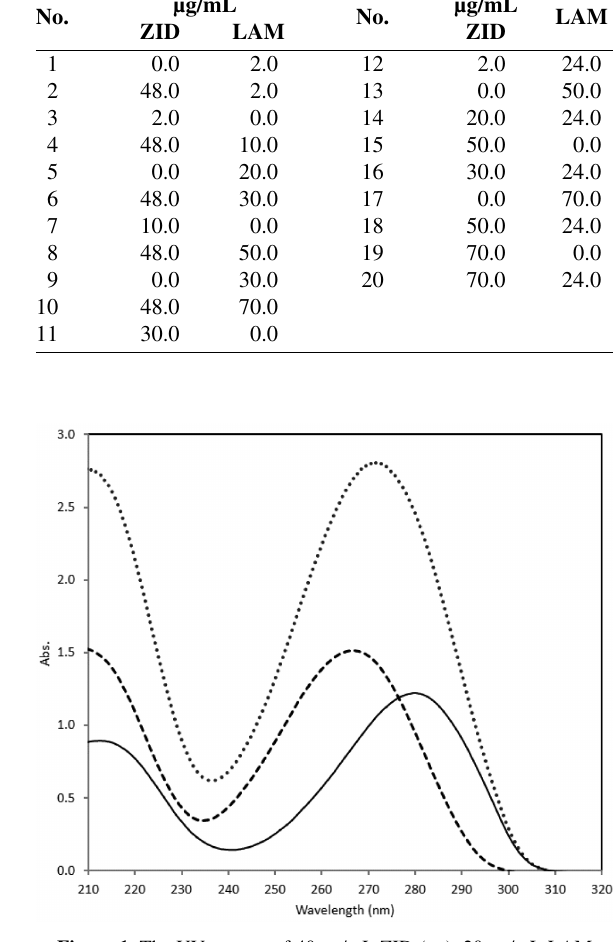
Figure 1. The UV spectra of 40 μg/mL ZID (---), 20 μg/mL LAM (—) and their mixture ( … ) in pH 1.2